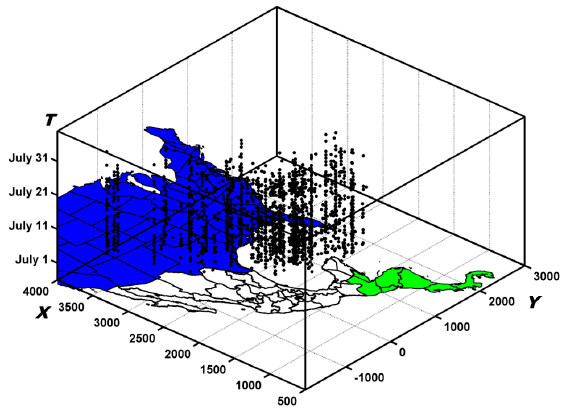
Figure 1. A real-world example of spatio-temporal Twitter events.